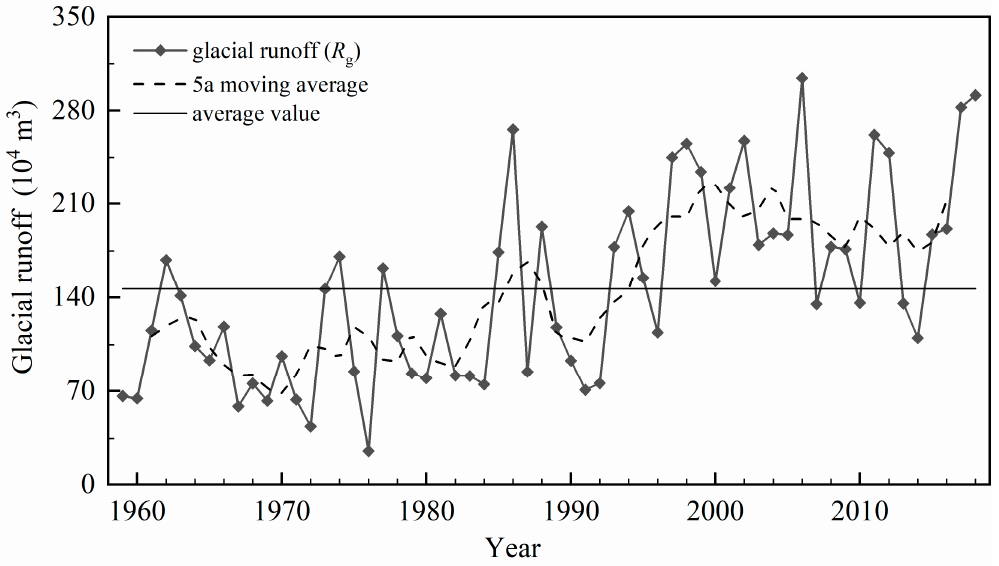
Figure 6. Variations of glacial runoff ( R g ) with its five-year moving average (5a) curve and its average value for Urumqi Glacier No. 1 from 1959 to 2018.